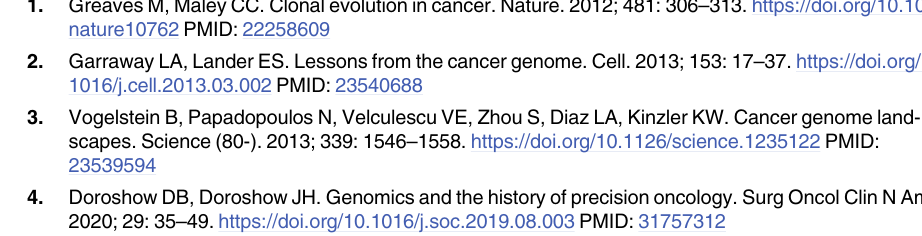
S1 Table. Differential gene expression analysis results and annotations. Showing the effect of our selected candidate genes on the over-expression and under-expression of genes in each dataset, reported as the proportion of the total number of genes whose gene expression levels get altered when the specified gene is mutated. S2 Table. Gene-expression files. Showing results of control experiments (with well-known genes) to select best gene-expression files and normalization of values for further processing. For each data set with multiple gene-expression files, a single best one was chosen to include in expression matrices and downstream differential gene expression. The best file was chosen as the one showing most effect (most numbers of genes affected) on the expression of other genes when three known cancer-drivers are mutated (BRCA1, BRCA2, TP53). S3 Table. Non-pathogenic mutations. Showing the heuristics used for the elimination of non-pathogenic genes from our